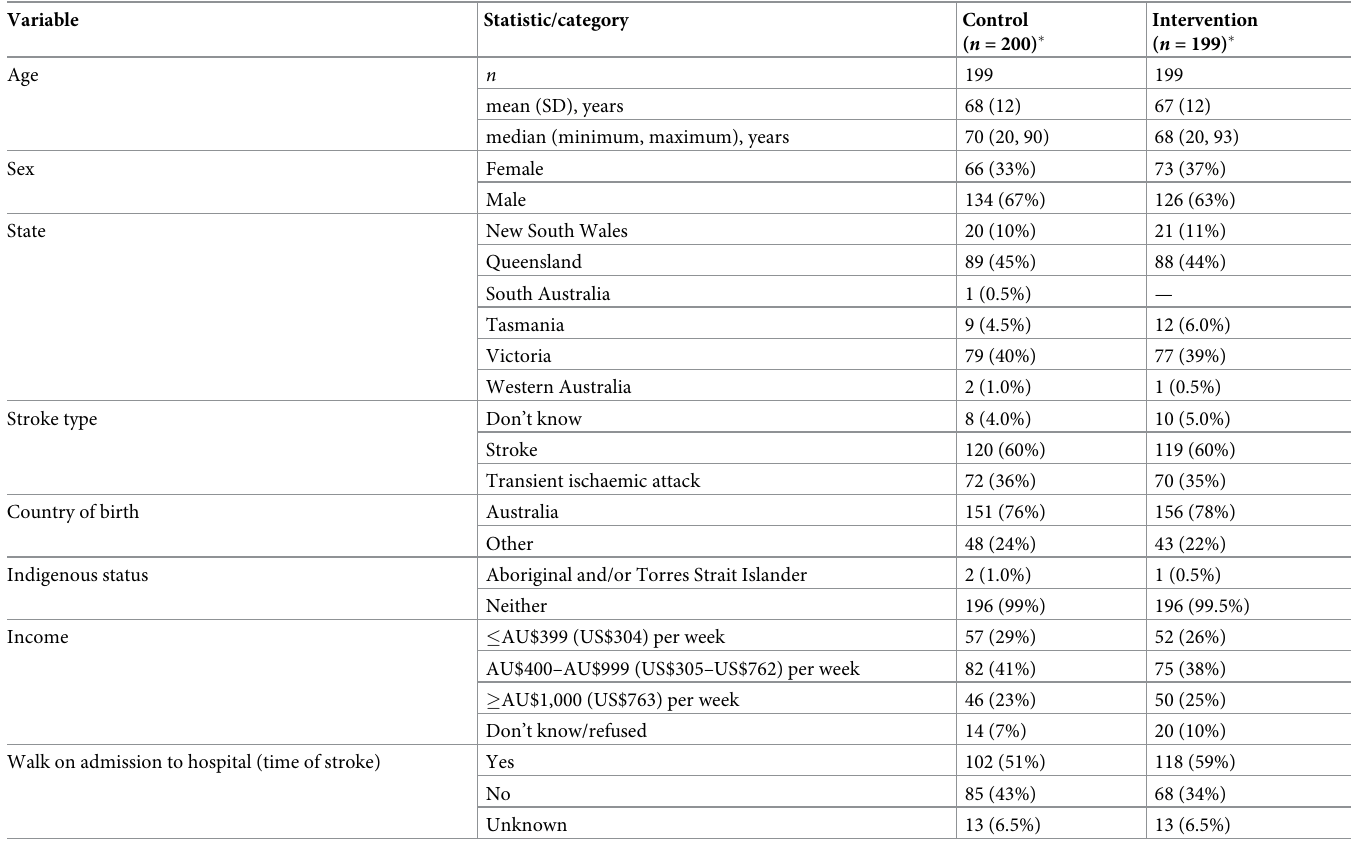
Table 1. Demographic characteristics by treatment group at